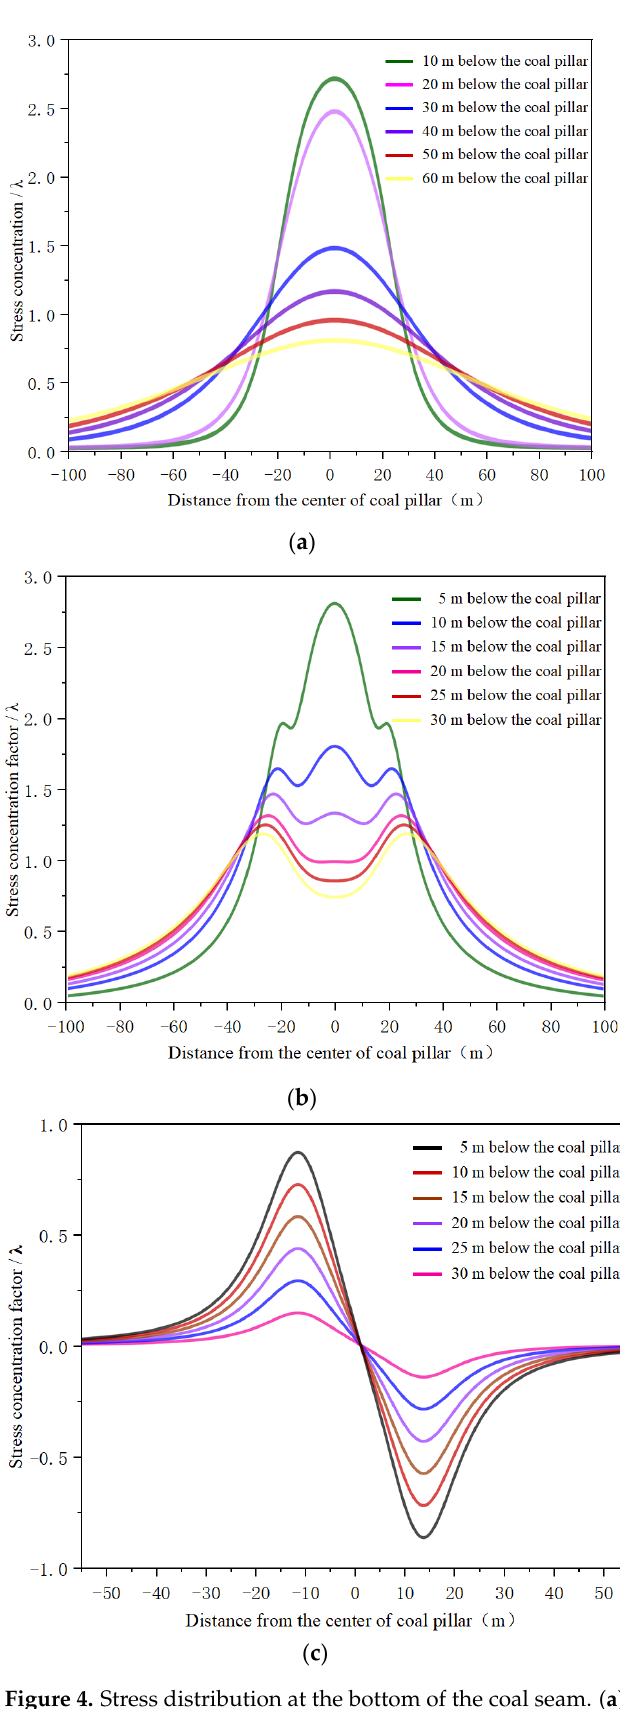
Figure 4. Stress distribution at the bottom of the coal seam. ( a ) Vertical stress distribution; ( b ) Hori- zontal stress distribution; ( c ) Shear stress distribution.